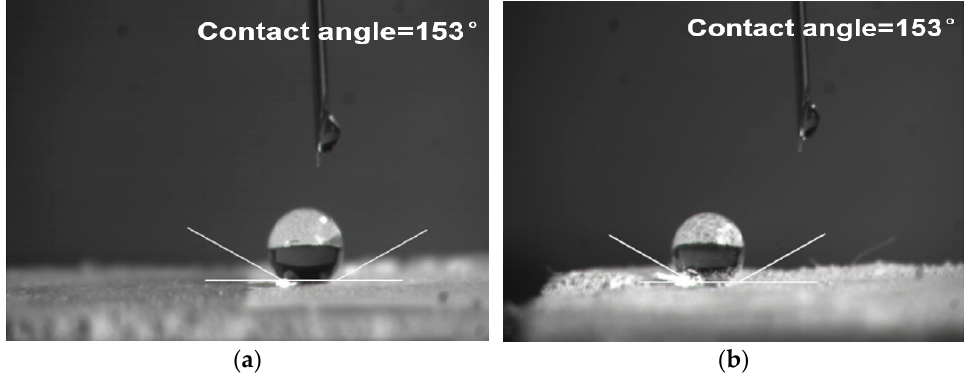
Figure 8. Measurement of contact angle of the water droplet on TiO 2 -OA material revealed that it has a superhydrophobic property; ( a ) and ( b ) show the contact angle tested at different